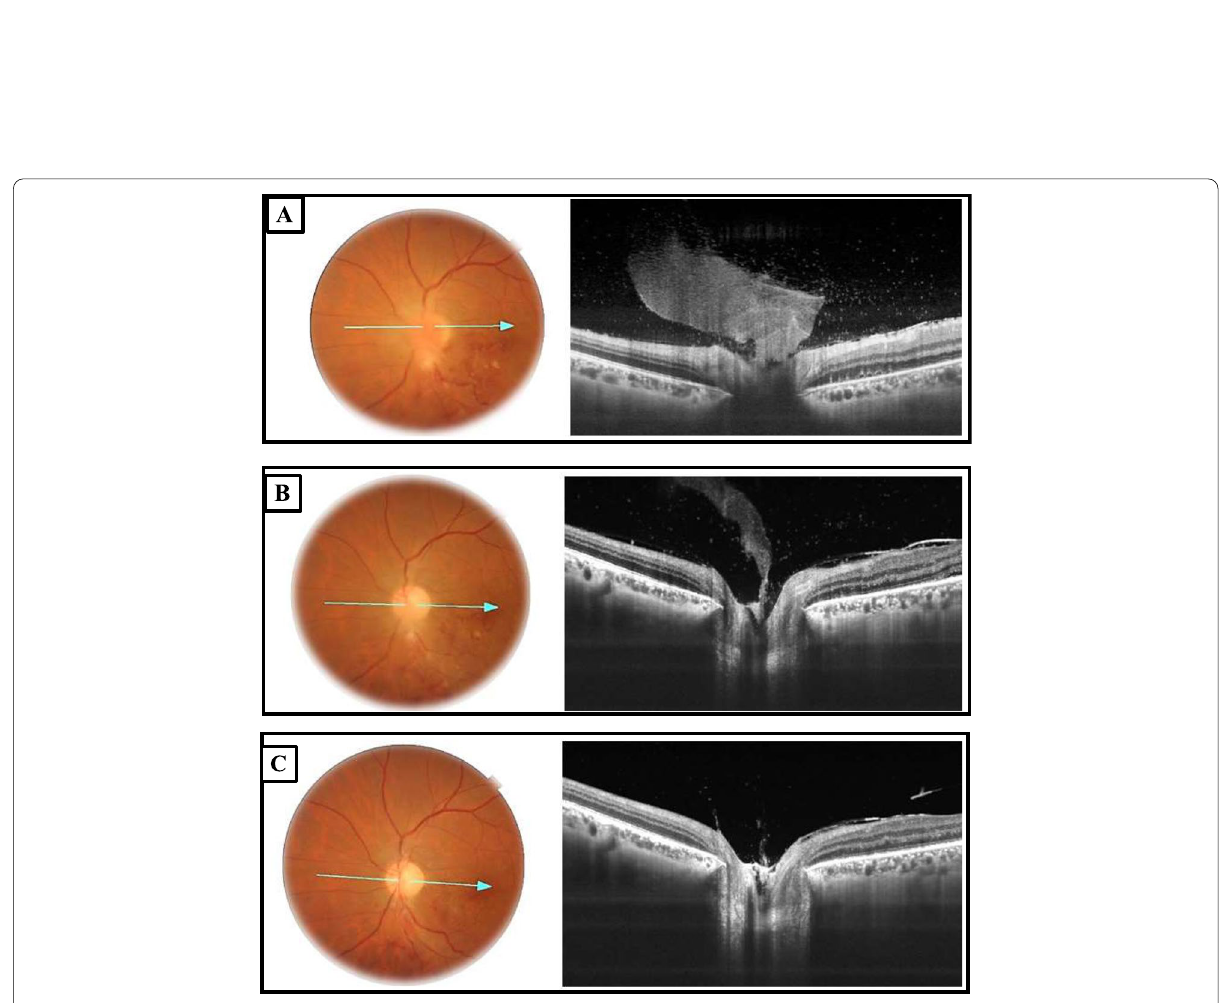
Fig. 4 Repeat fundus photographs and optic nerve SS OCT exhibiting the resolution of the pre-papillary vitreous infiltrate under treatment. ( A ) 2 days after the initiation of the treatment, the “funnel shaped” feature of the infiltrate is well-defined on the SS OCT as a hyperreflective lesion in the pre-papillary vitreous and the serous retinal detachment resolved. ( B ) Repeat SS OCT at day 6 showing that the pre-papillary vitreous infiltrate started resolving noticeably. ( C ) Follow-up at day 15, optic disc SS OCT revealing that the pre-papillary vitreous infiltrate resolved